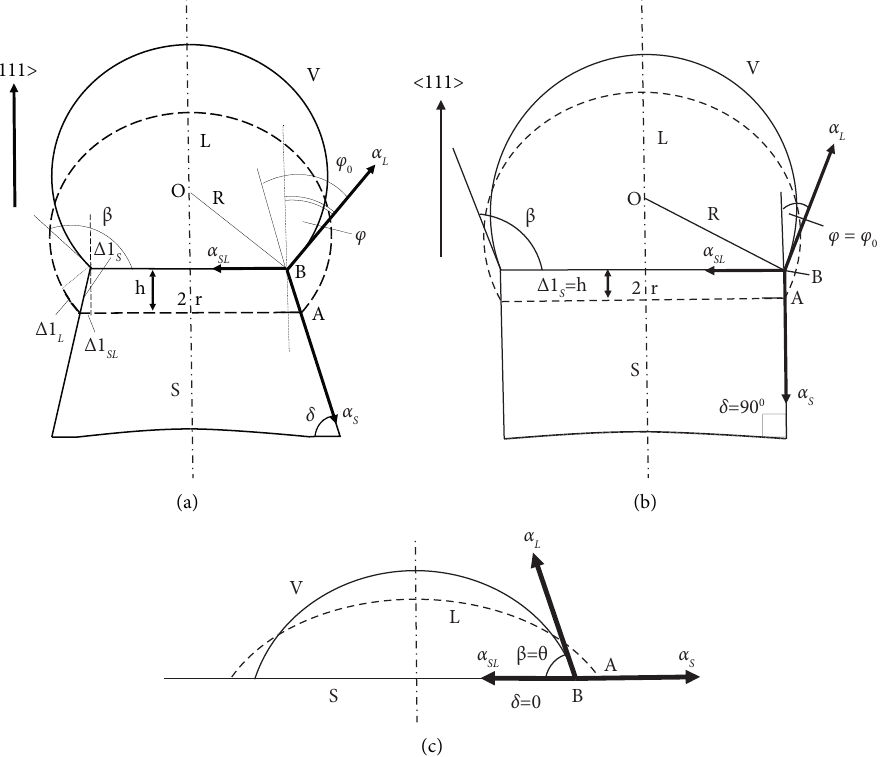
Figure 3: Scheme pairing section boundaries of three phases—solid, liquid, and gas for catalyst droplet at vertex tapered (0 < δ < 90 ° ), cylinder ( δ � 90 ° ) NWs with transverse facet {111}, and on the substrate ( δ � 0). φ —is the angle of the inclination segment surface of the catalyst droplet at the point A on the wetting perimeter to the growth axis NWs and φ 0 —is the angle of the inclination segment surface of the droplet to the displacement direction of the TPL.